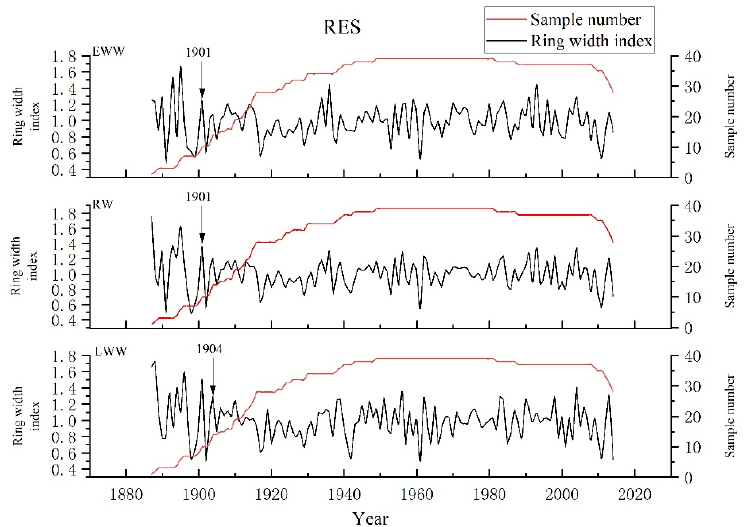
Figure 4. RES of EWW, LWW and RW and the samples of Pinus taiwanensis Hayata in the Tongbai